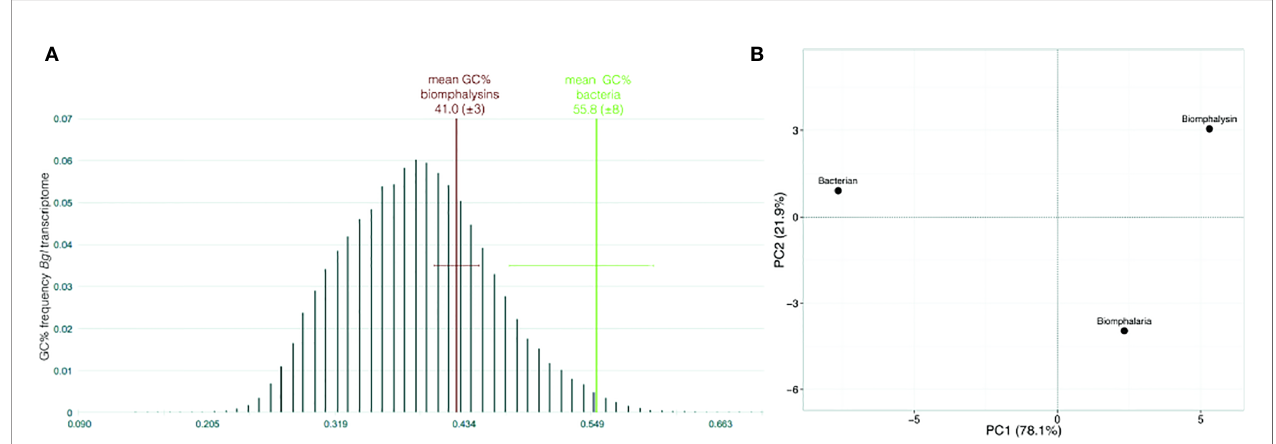
FIGURE 3 | Nucleotide support for domestication. (A) Box-plot representation of GC content and (B) principal component analysis on codon usage comparing nucleotide sequences of biomphalysins (N = 23) with other Biomphalaria glabrata sequences ( ± 1700 bp; N = 25) and bacterial toxin sequences (N = 13). Distribution of GC% was indicated for Biomphalaria glabrata transcripts while only the mean and standard deviation were indicated for biomphalysin and bacterial toxin